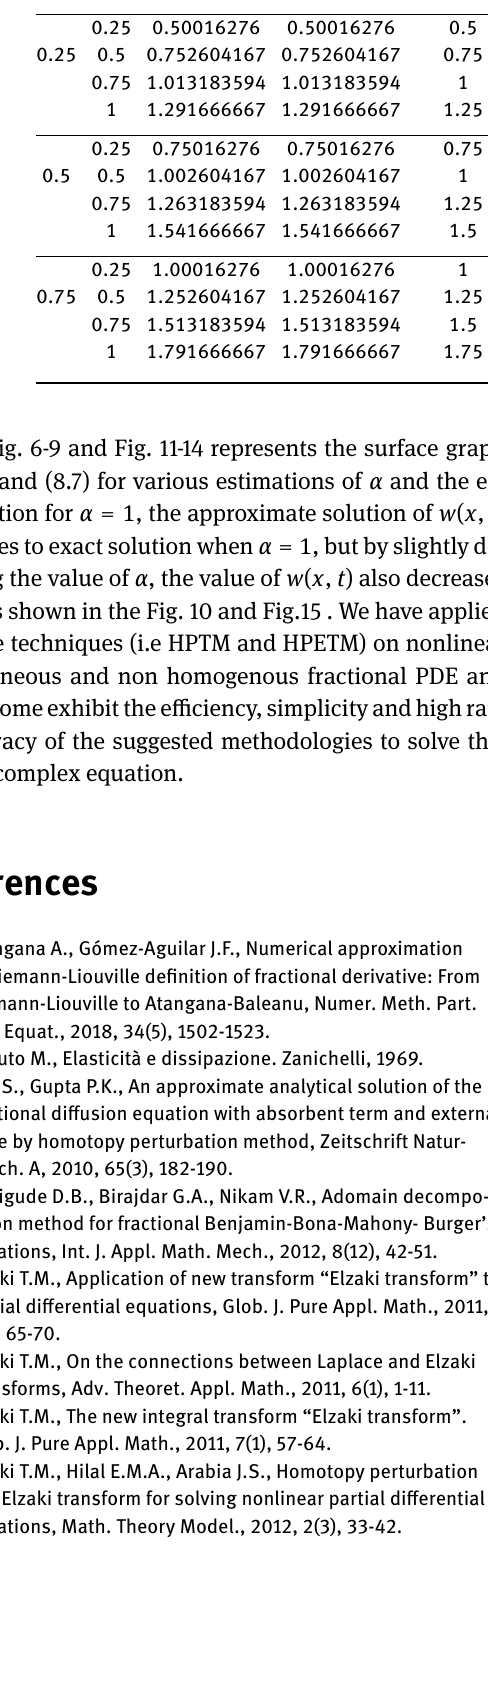
Table 3: Approximate solution of Inviscid Burger’s Equation (6.7) and (8.7) up to fourth order( α = 1 ) x t w HPETM w HPTM w abs.error || w 1 || || w 2 || || w 3 || (approx.) (approx.) (exact